Question: What style of plot is this figure drawn as?
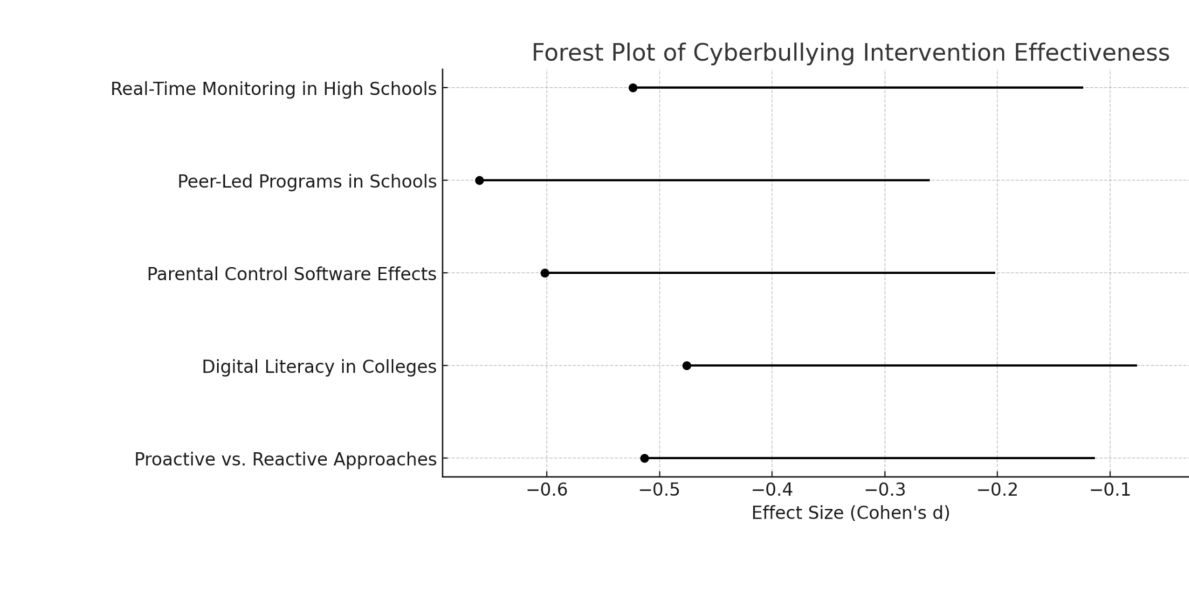
Answer: forest